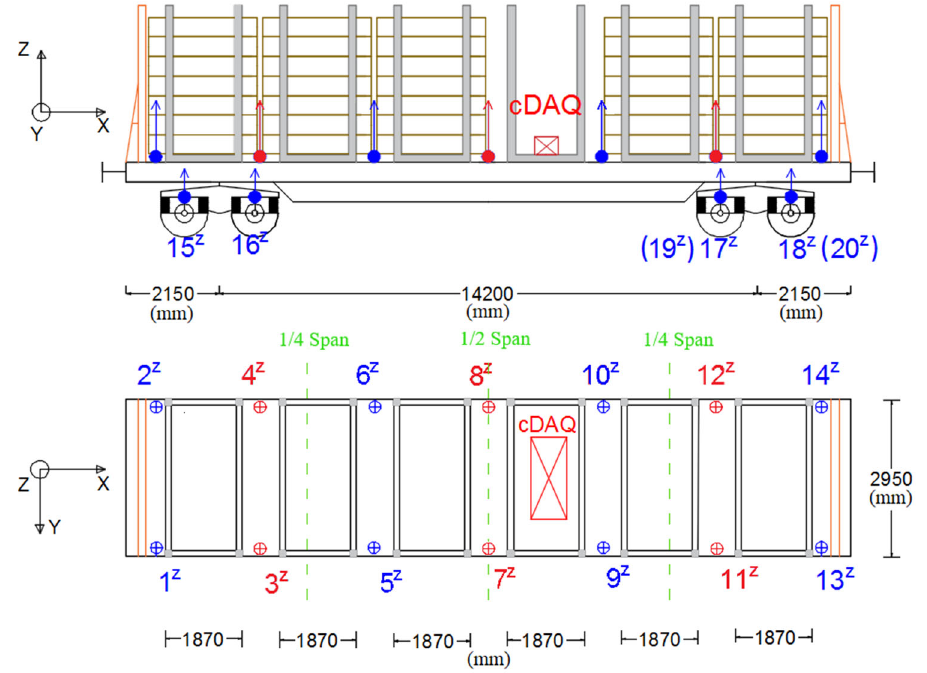
Figure 6. Dynamic tests of Sgnss wagon: measurement setup (reference points in red and mobile points in blue).